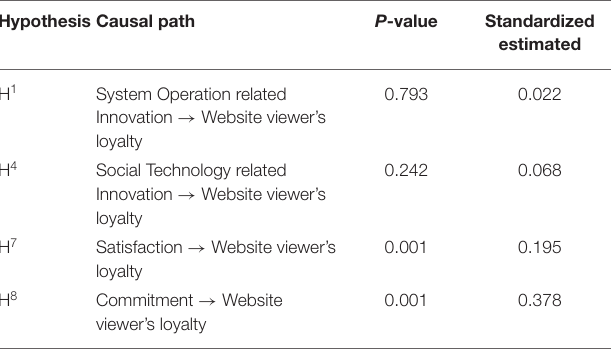
TABLE 6 | Results of direct effects in structural